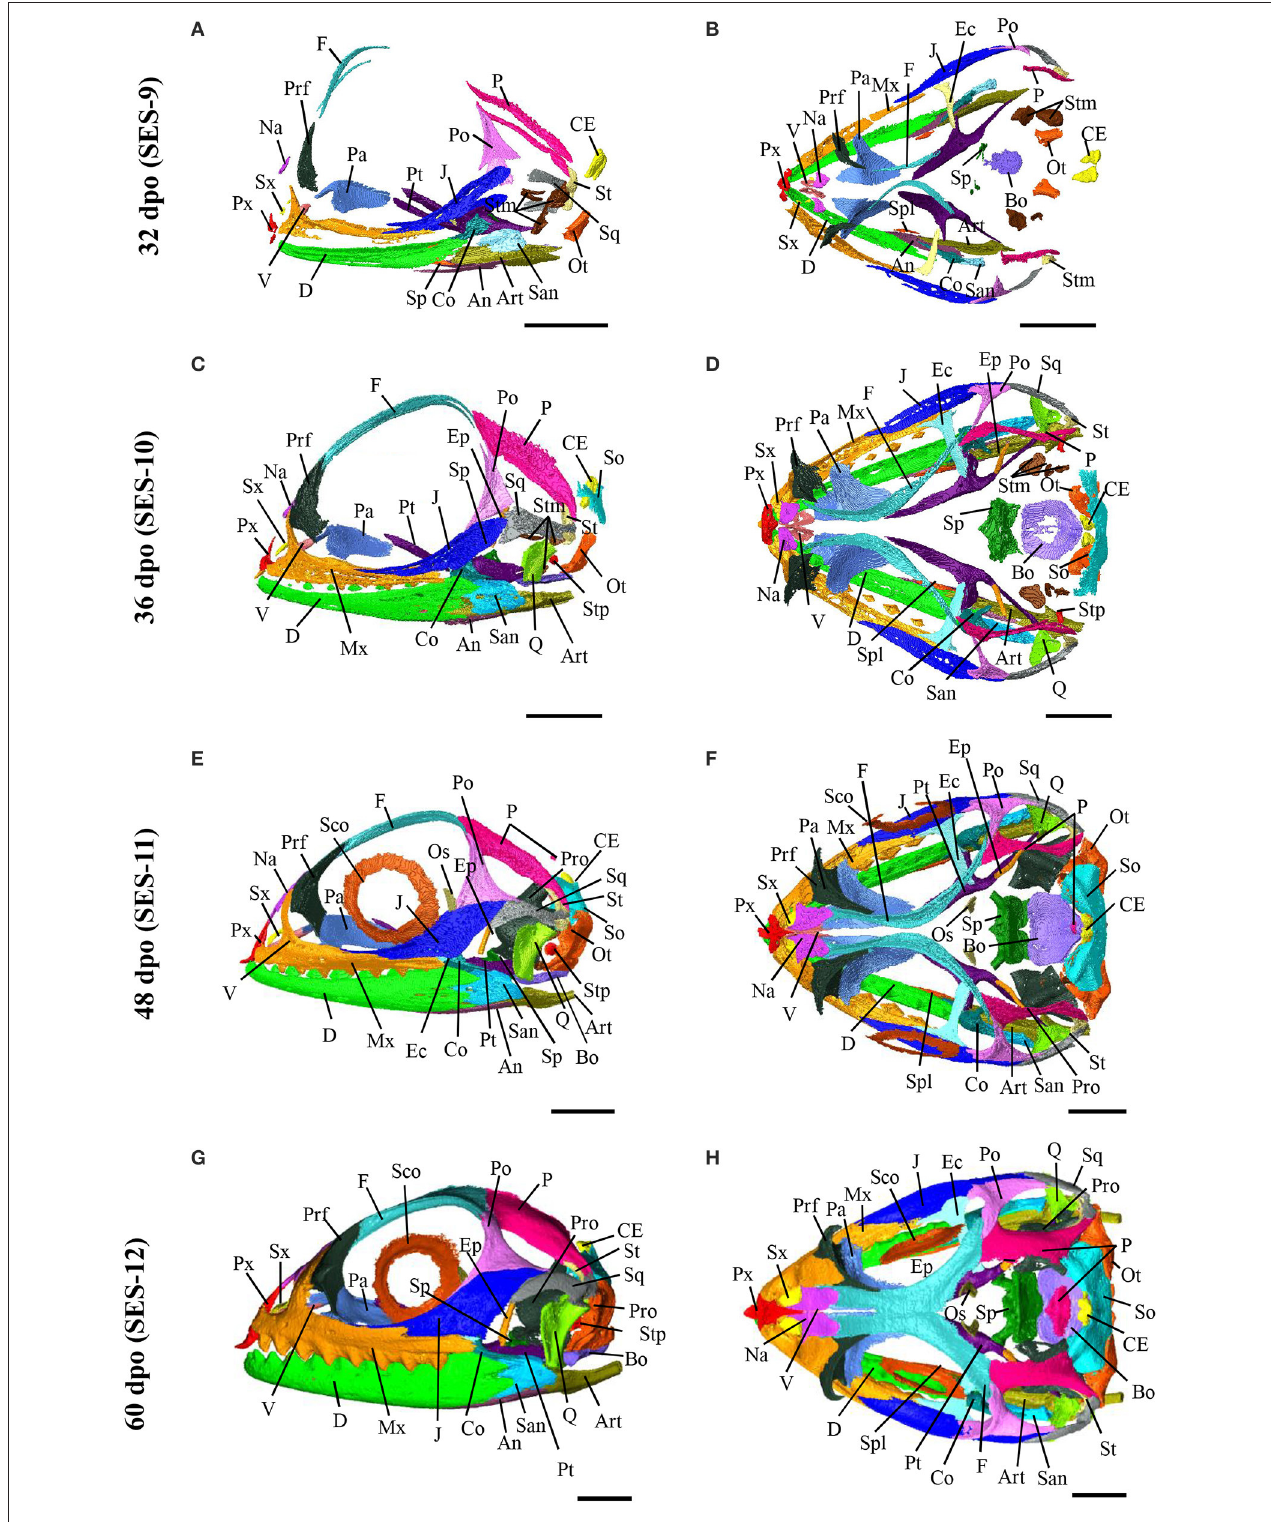
FIGURE 7 | Embryonic development of skull bones in Pogona vitticeps , part 2. Lateral (A,C,E,G) and dorsal (B,D,F,H) views of developing skull in Pogona vitticeps embryos at 32 dpo (A,B) , 36 dpo (C,D) , 48 dpo (E,F) , and 60 dpo (G,H) . For further details, see Figure 6 .